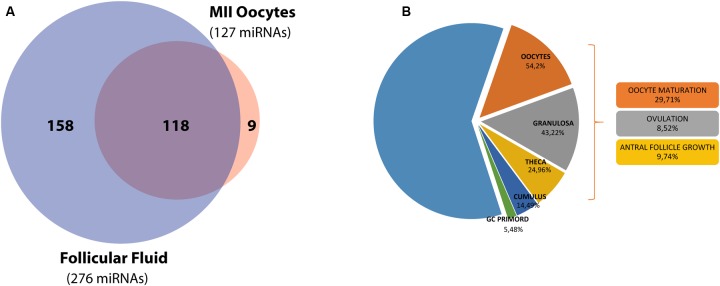
miRNA distribution in the ovarian follicle and functional analysis of the target genes. (A) Venn diagram shows the overlap between miRNA sets in hFF and the mature MII oocyte. (B) A second diagram shows miRNA target expression and function inside the ovarian follicle.